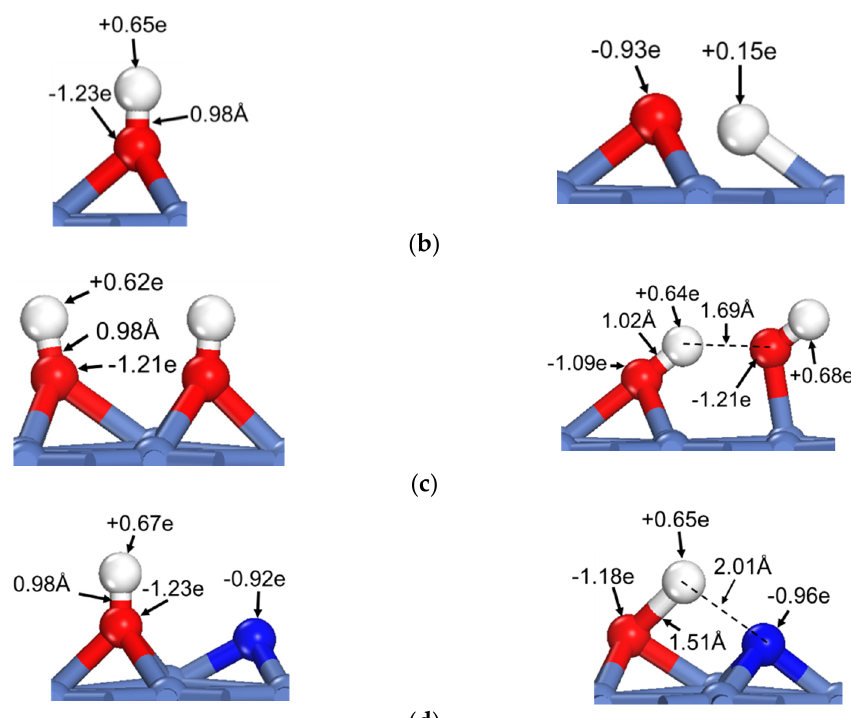
Figure 3. The dehydrogenation of O–H on Ni(111) surface: ( a ) The activation energies of dual path dehydrogenation of OH*, ( b ) The initial and transition state structures and charge distributions of individual OH* dehydrogenation, ( c ) The initial and transition state structures and charge distributions of OH-catalyzed OH* dehydrogenation, ( d ) The initial and transition state structures and charge distributions of N-catalyzed OH* dehydrogenation.